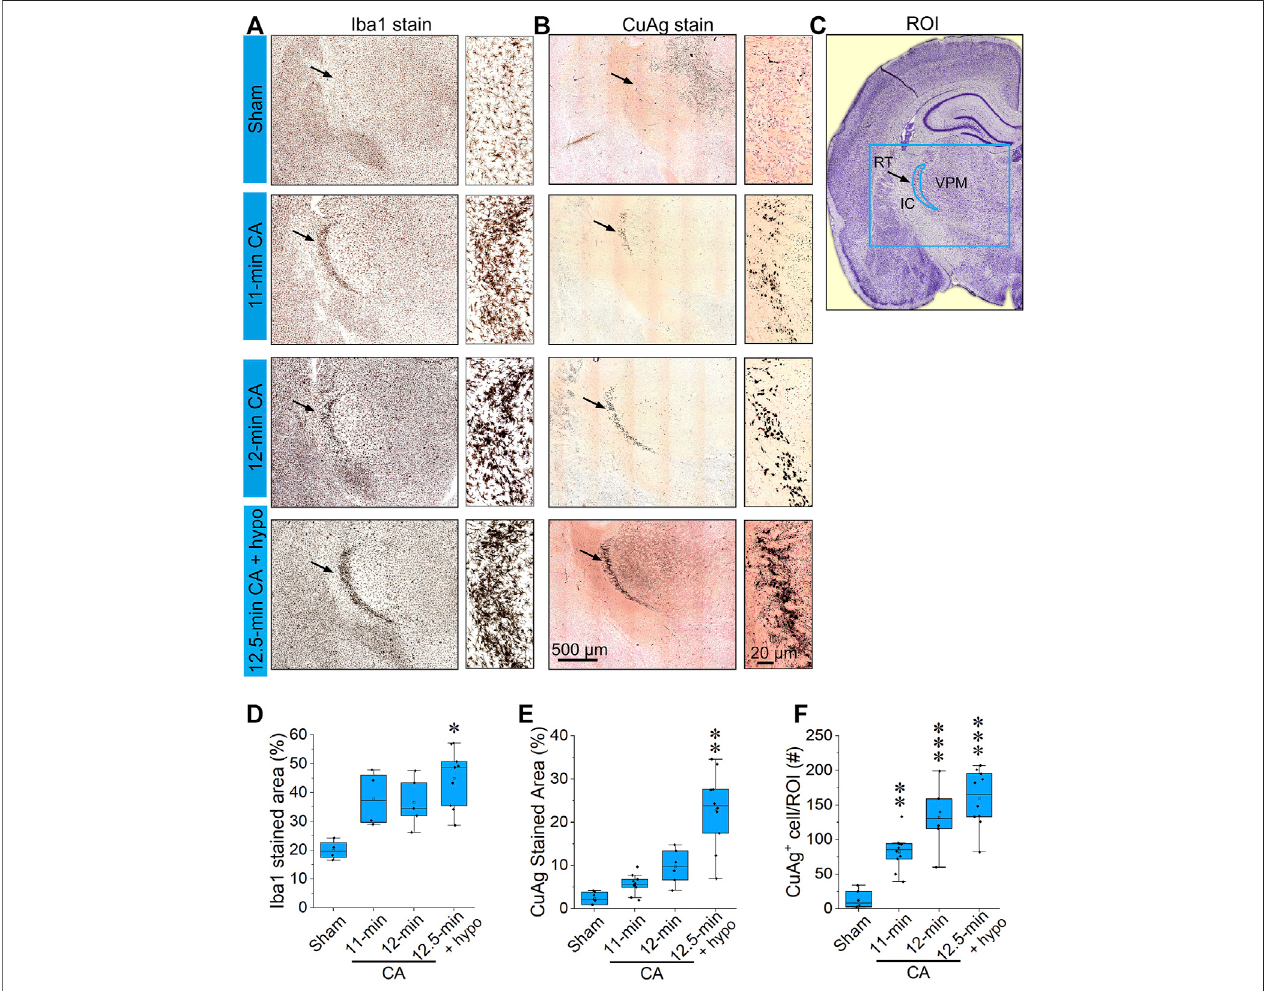
FIGURE 3 | CA induces pronounced microglial activation and neurodegeneration in the thalamic reticular nucleus (A,B) Representative photomicrographs of Iba1 and Amino Cupric Silver (CuAg) stains in the reticular nucleus 24 h after 11; 12; 12.5 min CA and sham-operated rats (C) Schematic illustration of the reticular nucleus, thebluerectangleindicatesthecapturedinAandB;thebluecrescent-shapeindicatestheanalyzedregion. (D – F) ThebargraphsshowpercentageofIba1stainedarea, CuAg-stained area, and the number of CuAg-stained cell in the ROI. It can be noted that both Iba1 and CuAg stains in RT from the CA rats show a remarkable increasecomparedtosham(Nestedone-wayANOVAwithDunnett ’ smultiplecomparisonstest; p p < 0.05, pp p < 0.01, ppp p < 0.001vsshamgroup;Dataarepresented asindividual valueswithmedian andinterquartilerange. Both leftandright RTof2,3 stainedslides fromeach of3 – 6animals/groupwereanalyzed). Scalebars represent 500 μ m (low-power images) and 20 μ m (high-power images).